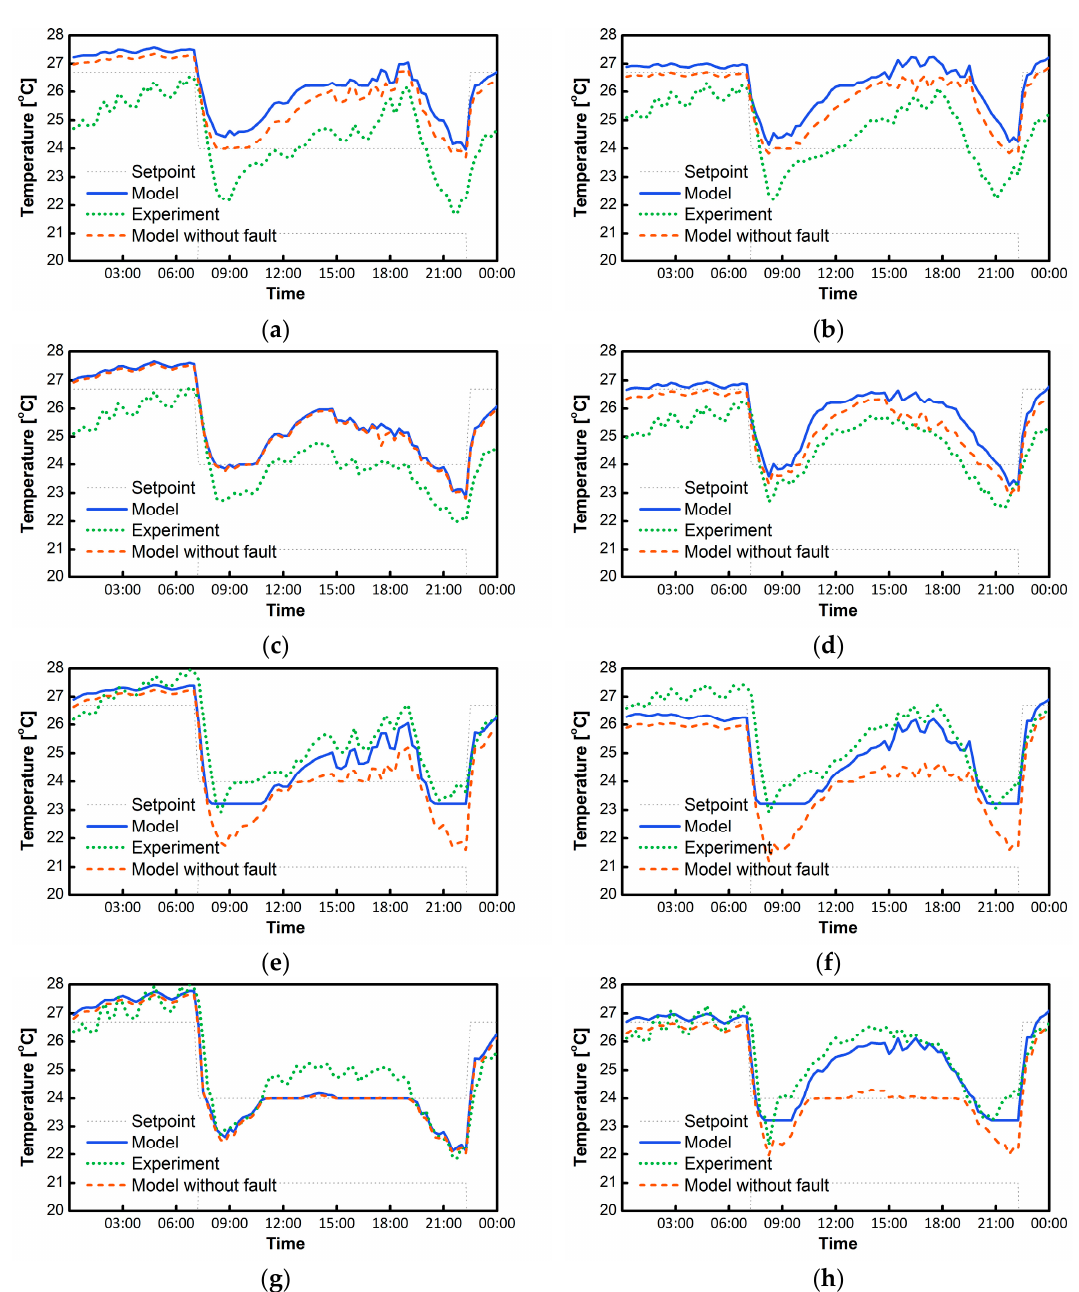
Figure 12. Room temperature comparisons between experiments and simulations: thermostat measurement bias. ( a ) − 2.2 °C bias in two rooms: room 105; ( b ) − 2.2 °C bias in four rooms: room 105;